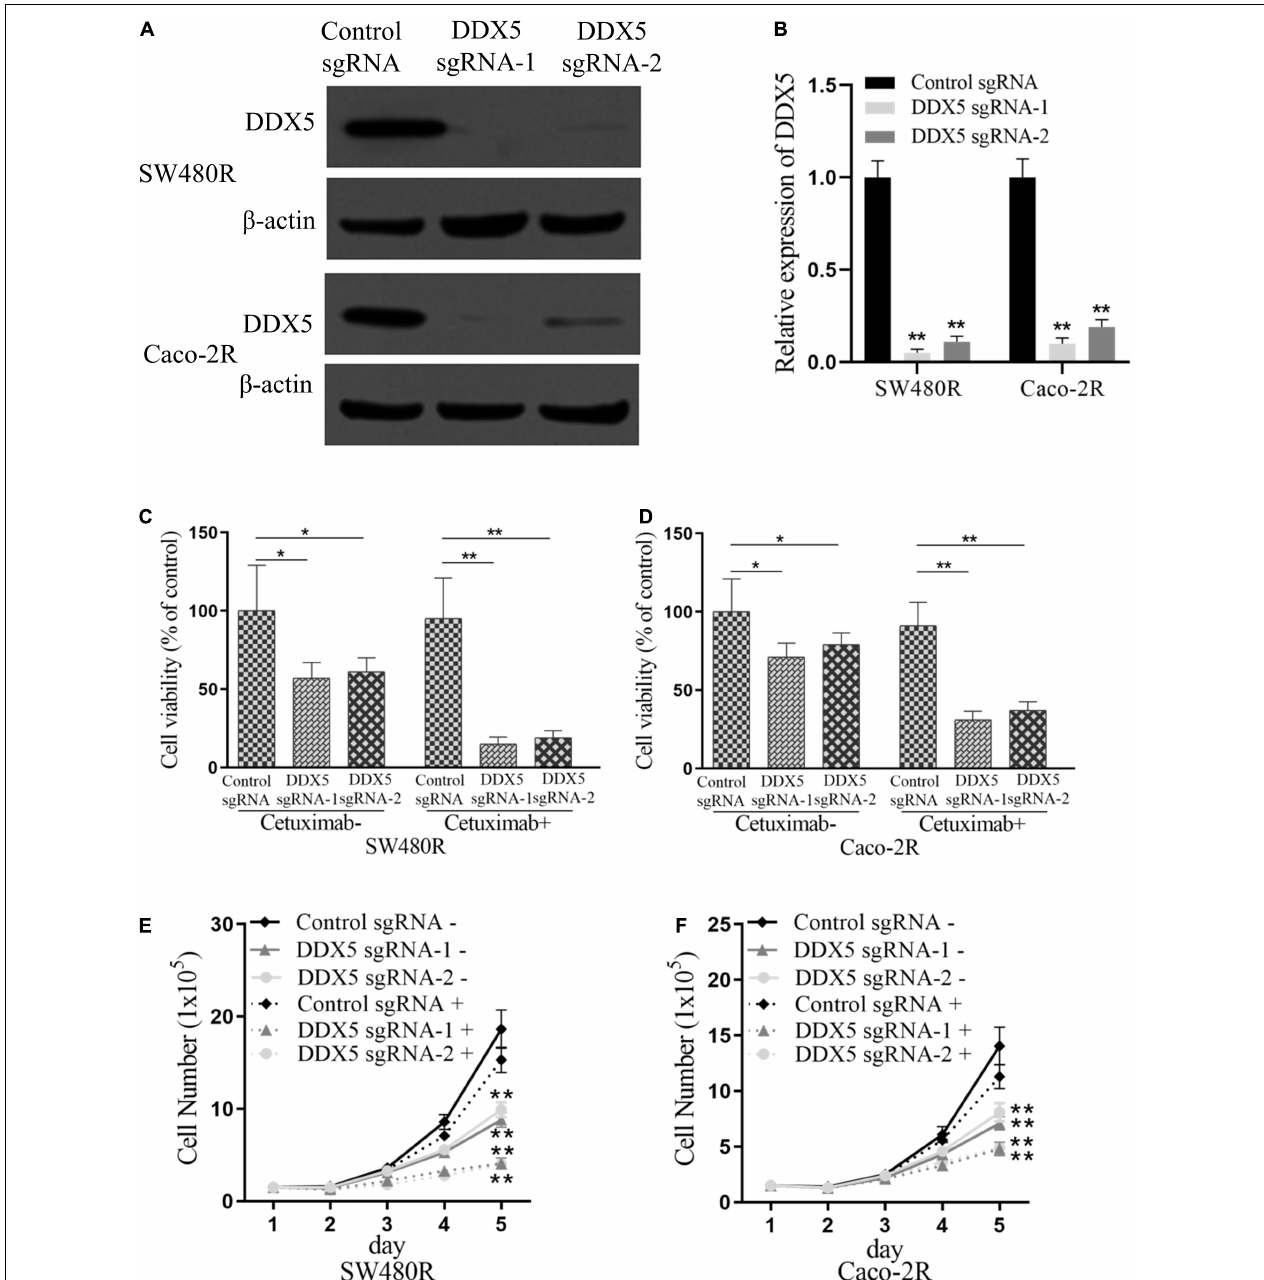
FIGURE 4 | Suppression of DEAD-box helicase 5 (DDX5) inhibits the proliferation of cetuximab-resistant colon cancer cells. Western blotting assay for the levels of DDX5 in (A) SW480R and (B) Caco-2R colon cancer cells. β -actin served as a loading control. (C) SW480R and (D) Caco-2R cells were incubated with or without cetuximab for 72 h, and cell proliferation was determined using the Cell Counting Kit-8 (CCK-8) assay. (E) SW480R and (F) Caco-2R cells were grown in six-well plates, and the cell number was determined. Cetuximab+ and cetuximab– represent the culture media with and without 10 µ g/ml cetuximab, respectively. Data were presented as mean ± SD of three independent experiments. * p < 0.05; ** p <